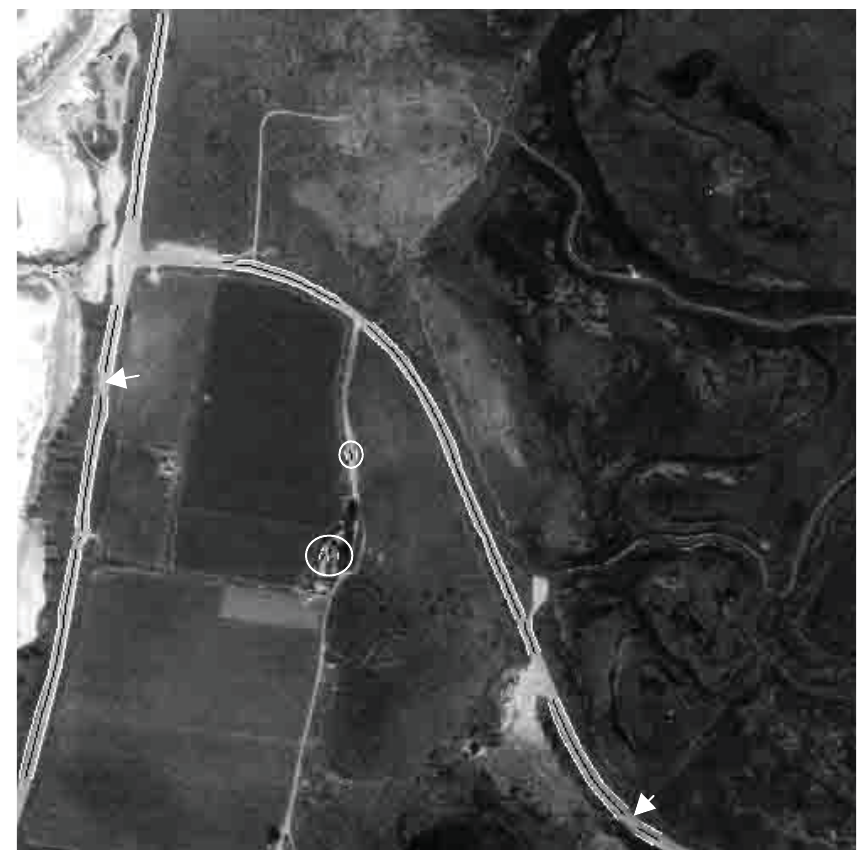
Fig. 9 – Results obtained with the medium-resolution